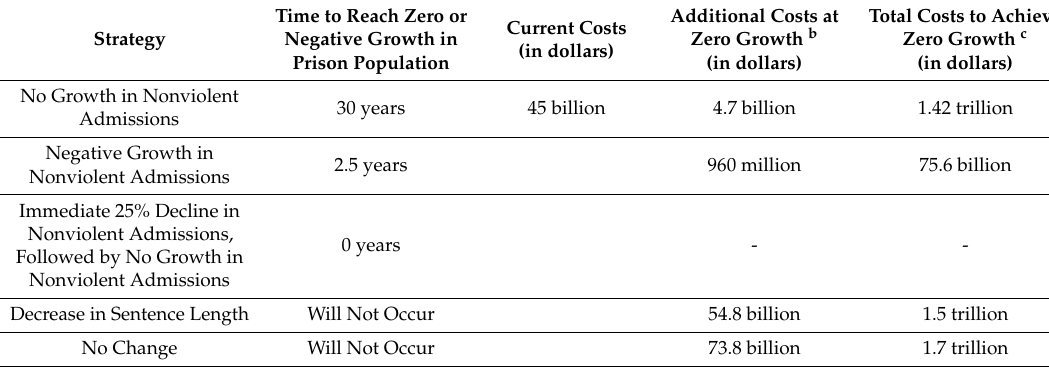
Table 1. The Costs of Momentum: The Additional Costs of the Population at Zero Growth a . Additional Costs at Total Costs to Achieve Time to Reach Zero or Current Costs Zero Growth b Zero Growth c Strategy Negative Growth in (in dollars) Prison Population (in dollars) (in dollars) 30 years 45